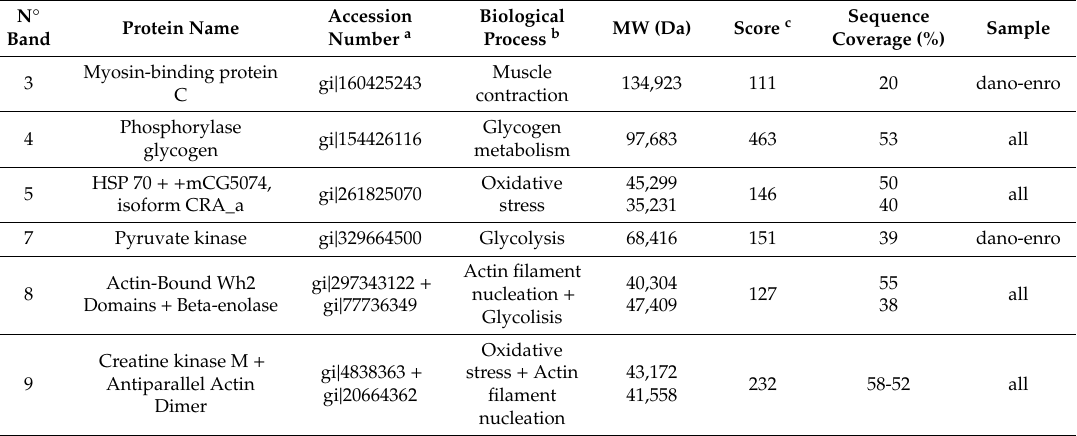
Table 3. Identification of oxidized myofibrillar proteins according bands selected by Western blot from blank and treated samples with danofloxacin or